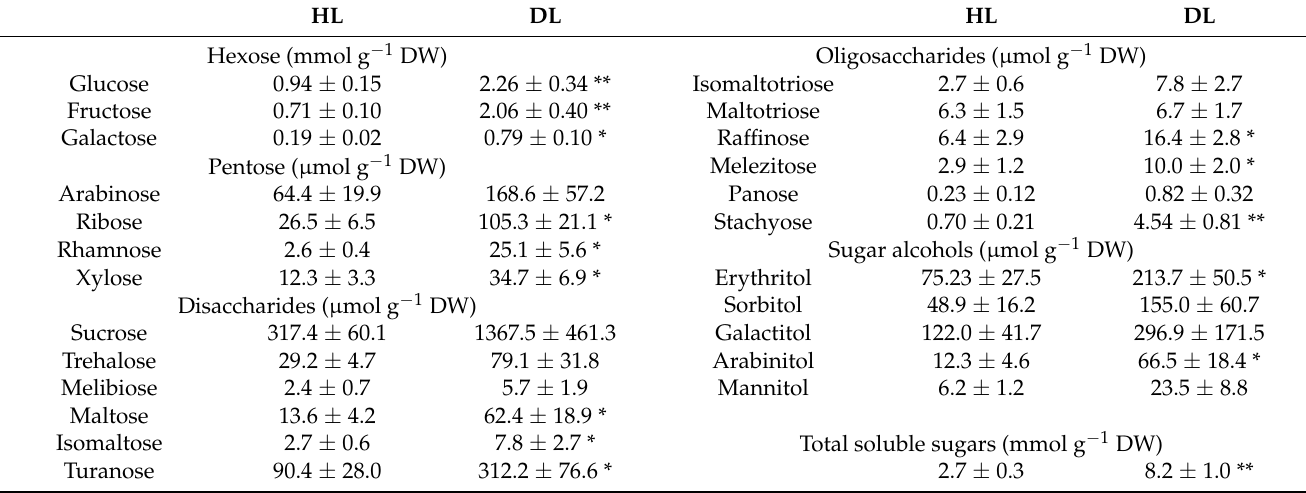
Table 1. Content of soluble sugars in HL and DL of R. serbica . Values are presented as means ± SE ( n = 5–6). Asterisks denote significant differences between treatments and respective controls accord- ing to the t -test (* p < 0.05, ** p <